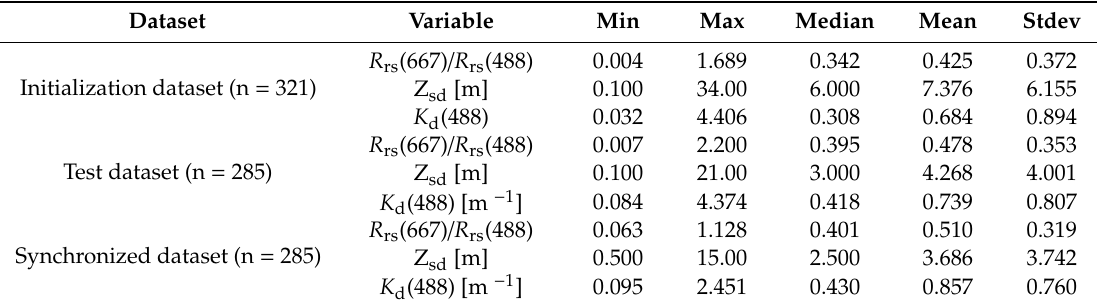
Table 1. Descriptive statistics of field-measured optical properties in the initialization dataset, test dataset, and synchronized dataset. Stdev is the standard deviation. Note that the K d (488) is derived from R rs data using neural network model developed by Chen et al.